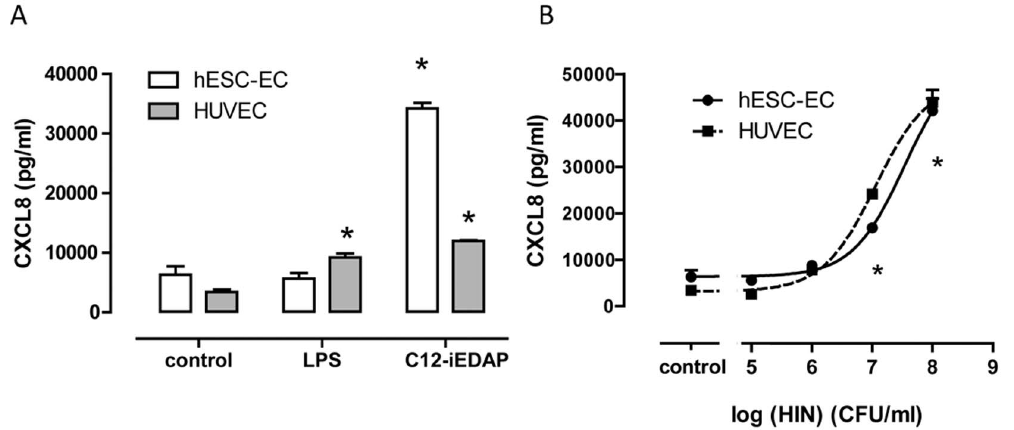
Figure 3. Responses of hESC-EC and HUVEC to 24 hour infection with Heamophilusinfluenzae. (A) Effect of LPS (1 m g/ml) or C12-iE-DAP (10 m g/ml) on CXCL8 release from hESC-EC and HUVEC after 24 hours. (B) Effect of Haemophilus influenzae (HIN) (10 5 –10 8 CFU/ml) on CXCL8 release from hESC-EC (solid line) or HUVEC (dashed line) after 24 hours. Data are mean 6 SEM; n=3 representative of 6 hESC-EC isolations. Statistical significance for responses to drugs or bacteria was determined by one-way ANOVA followed by Dunnett’s multiple comparison test (p , 0.05).